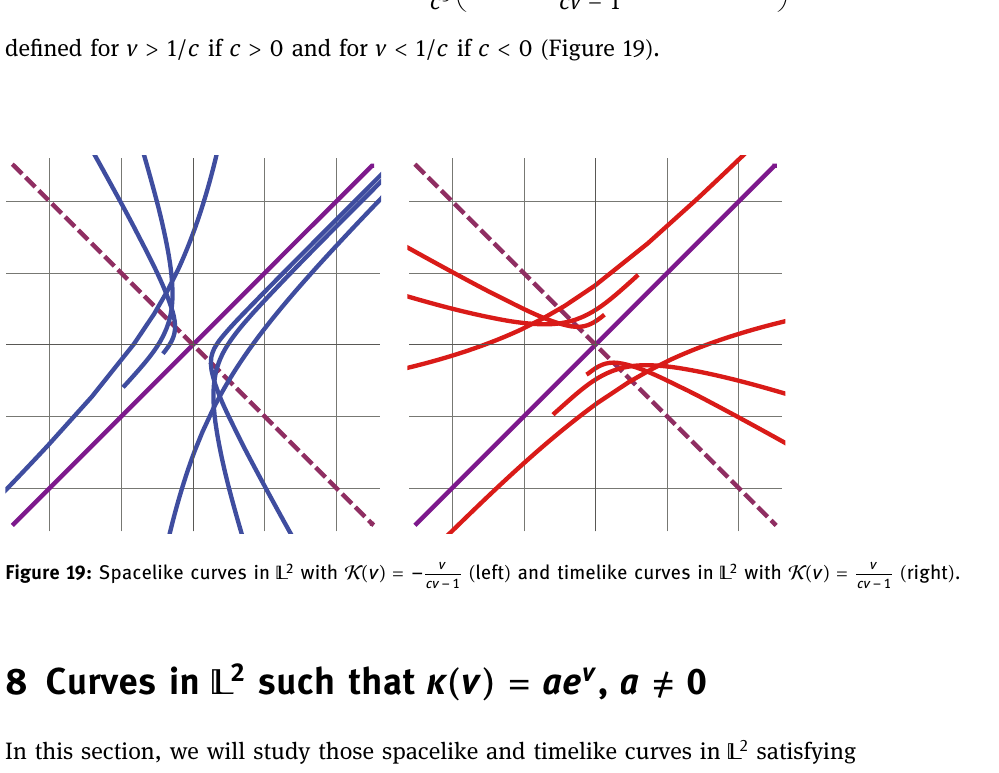
Figure 19: Spacelike curves in (cid:2) 2 with (cid:2) ( ) = v − v